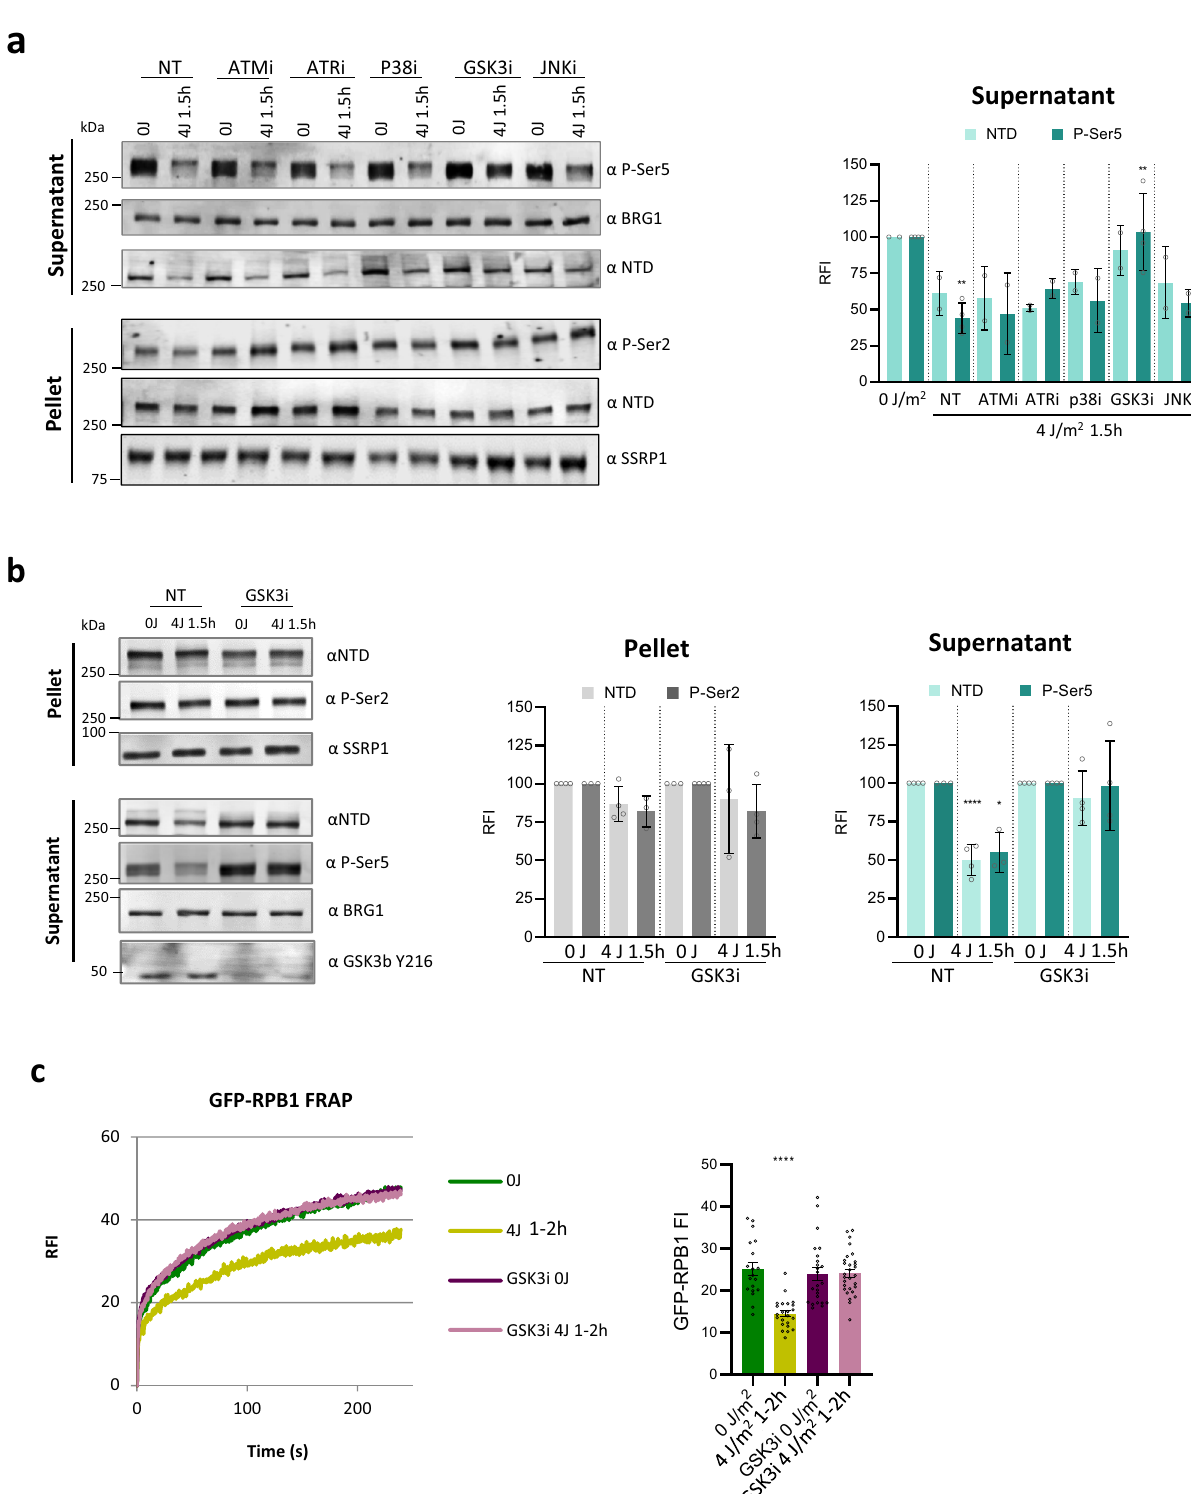
of kinases with established roles in the DNA damage and transcription stress responses, including ATM and ATR 61 , p38 MAPK62 , c-Jun N-terminal kinase (JNK) 63 , and glycogen synthase kinase 3 (GSK3) 64 . Interestingly, only the inhibition of GSK3, which was con fi rmed by reduced phosphorylation of Y216 65 , signi fi cantly prevented the UV-induced degradation of promoter-bound Pol II (Fig. 5a, b). In line with fractionation results, Pol II FRAP analysis after GSK3 inhibition showed that